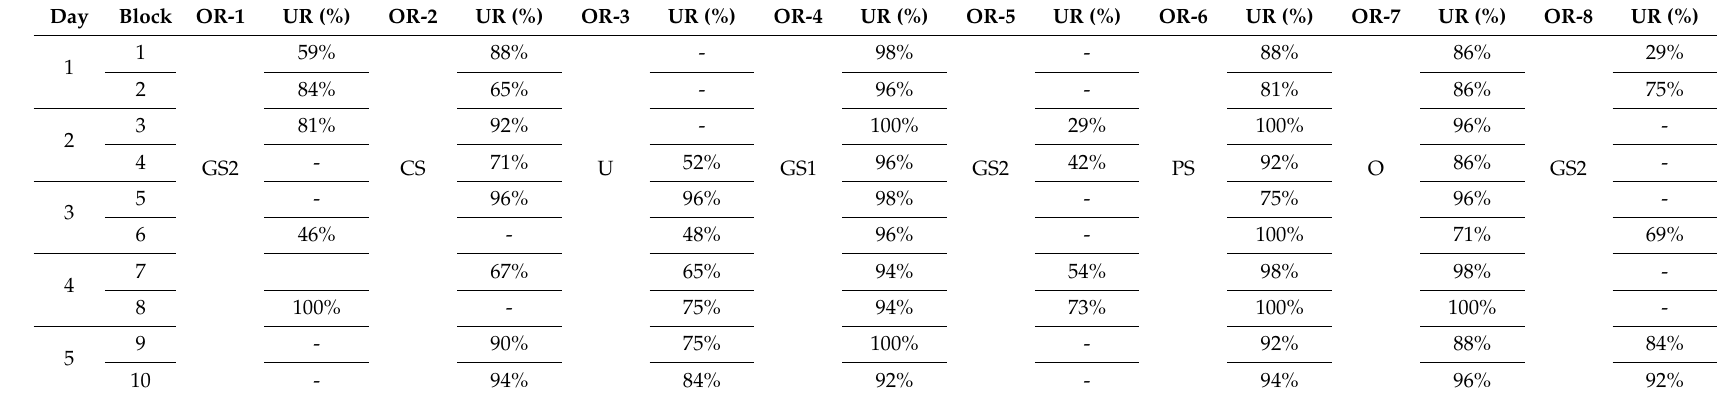
Table 4. Created schedule for Scenario 3 as a result of the goal programming